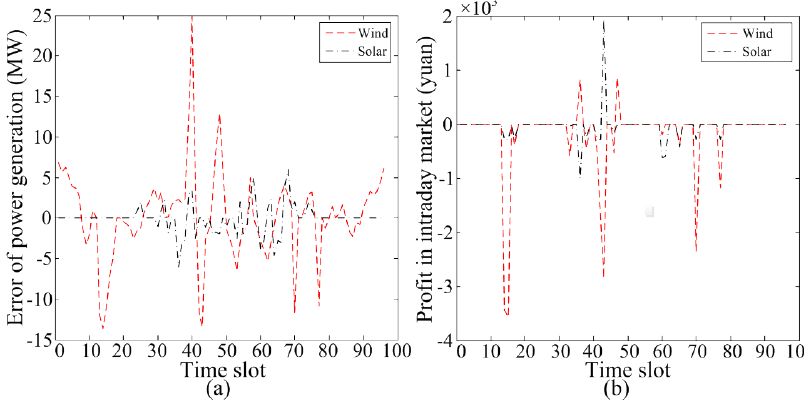
Figure 6. Simulation parameters and results in the intraday market: ( a ) difference between generating volume produced during the real-time operation and that scheduled in the day-ahead market; ( b ) profit of power producers in the intraday